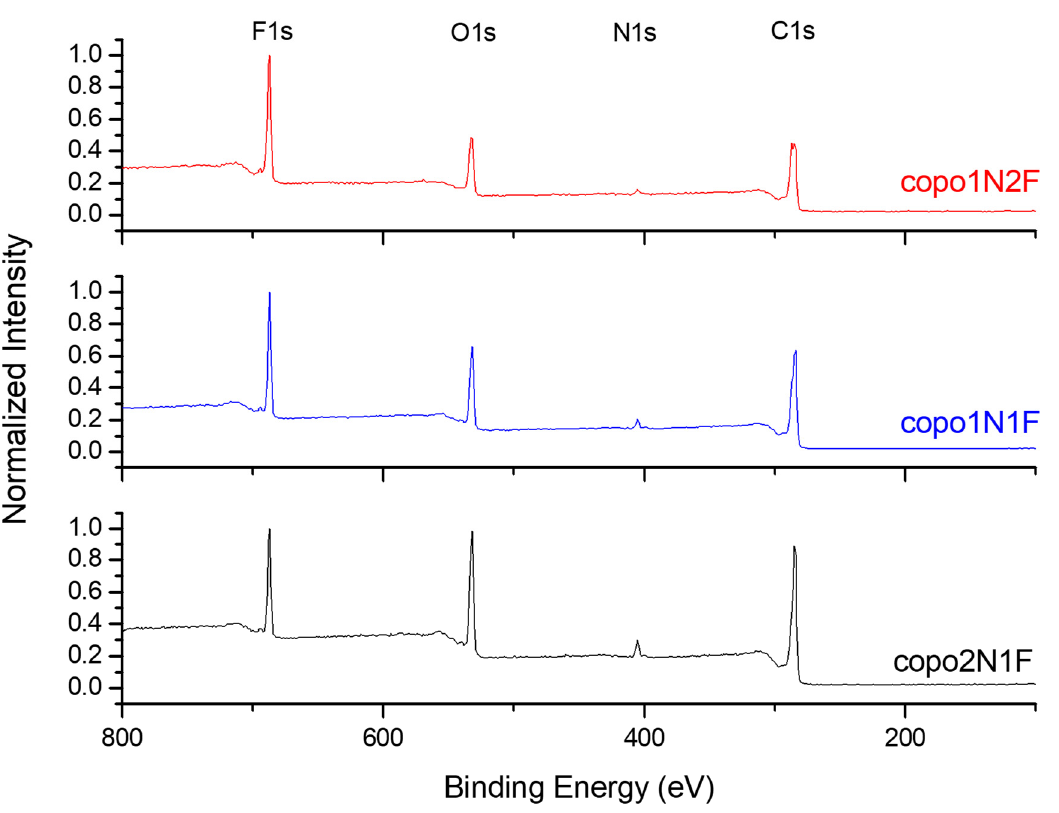
Figure 3. XPS results for the atomic survey of P(NPMA -co- PFPMA) at different compositions. For all three copolymers, their C1s core-level experimental data can be decomposed into minimum six components (Figure 4a). The first component is the C=C aromatic char- aliphatic C-C bonds are characterized by their binding energy at 285.0 eV, which has been taken as reference for calibrating the whole fitting process. The quaternary carbon of the